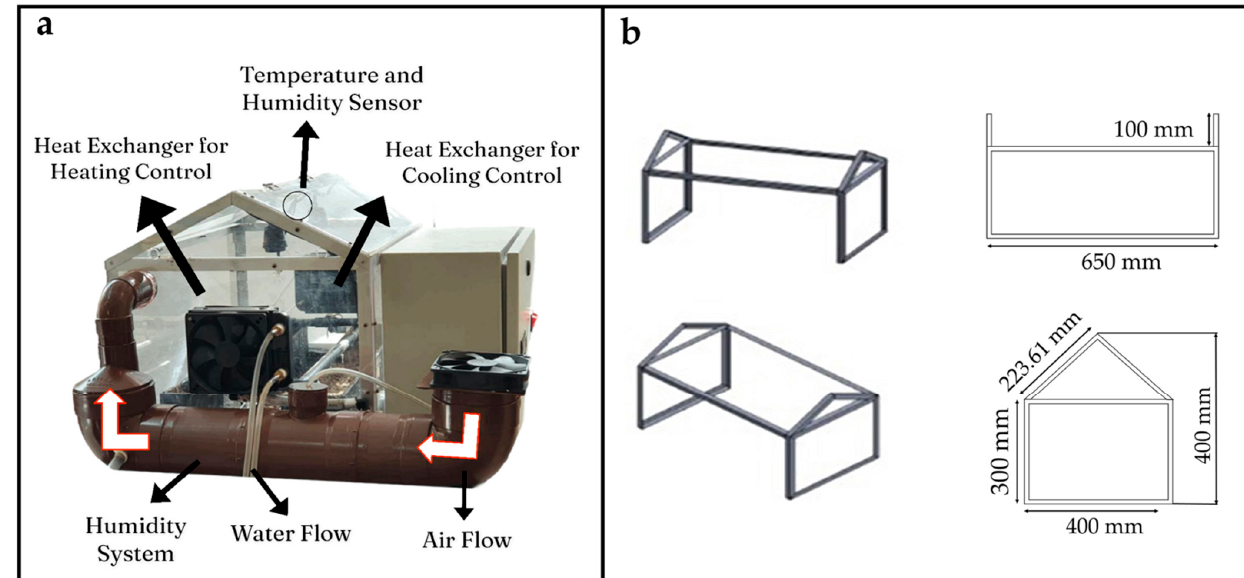
Figure 2. Components ( a ) and dimensions (mm) ( b ) of the micro-greenhouse.